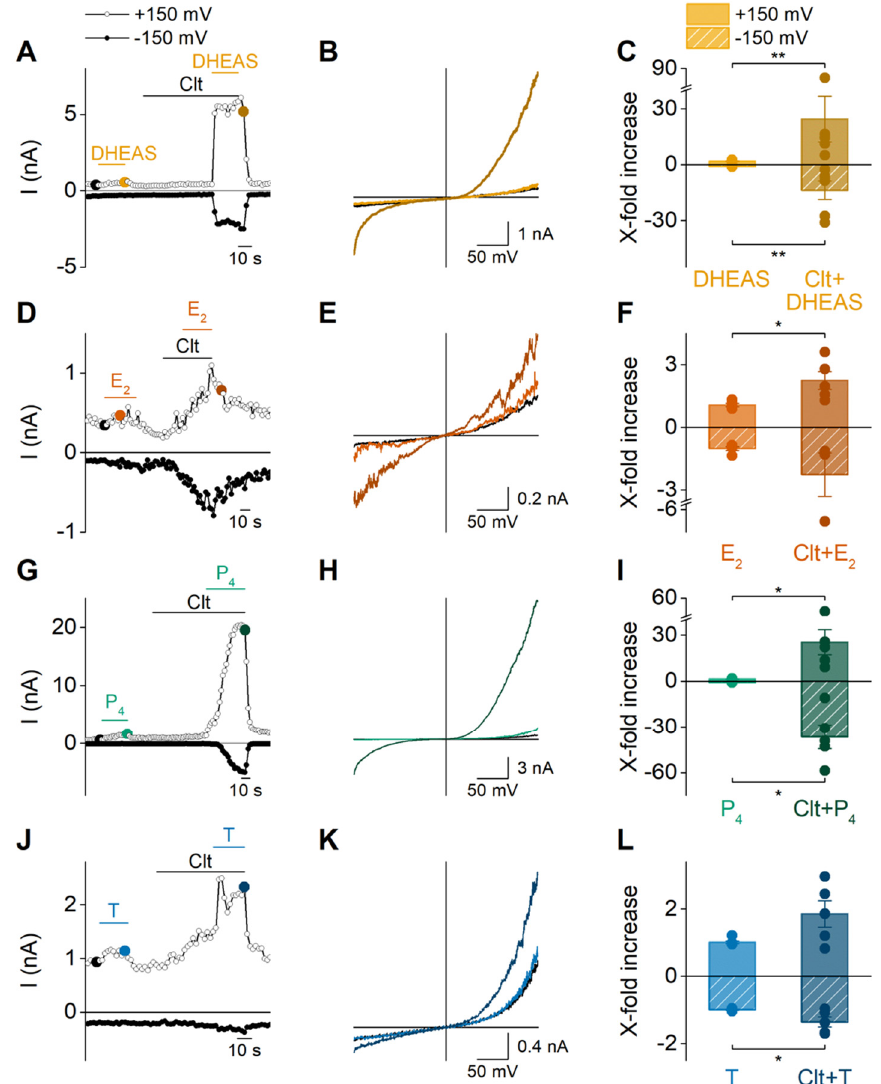
Figure 5. Potentiation of DHEAS, estradiol, progesterone, and testosterone responses by clotrimazole. ( A , D , G , J ) Time course of patch clamp experiments on HEK-TRPM3 cells upon application of 100 µM DHEAS, E 2 , P 4 , and T alone or in combination with 10 µM clotrimazole. All experiments were performed at room temperature. ( B , E , H , K ) The corresponding I-V curve of the indicated points in ( A , D , G , J ) after stimulation with DHEAS, E 2 , P 4 , and T, respectively. ( C , F , I , L ) X-fold potentiation of currents in absence and presence of Clt at − 150 mV (shaded) and +150 mV for DHEAS (n = 6), E 2 (n = 5), P 4 (n ≥ 5), and T (n ≥ 5), respectively. Data are represented as mean ± SEM. Statistical analysis using two-sample t-tests or Mann–Whitney tests between groups. p < 0.05 *, p < 0.01 **. p -values for ( C ): ±150 mV: p = 0.0051; ( F ): +150 mV: p = 0.0216 and − 150 mV: p = 0.0947; ( I ): +150 mV: p = 0.0437 and − 150 mV: p = 0.0105 with Welch correction; ( L ): +150 mV: p = 0.1709 and − 150 mV: p = 0.0358.